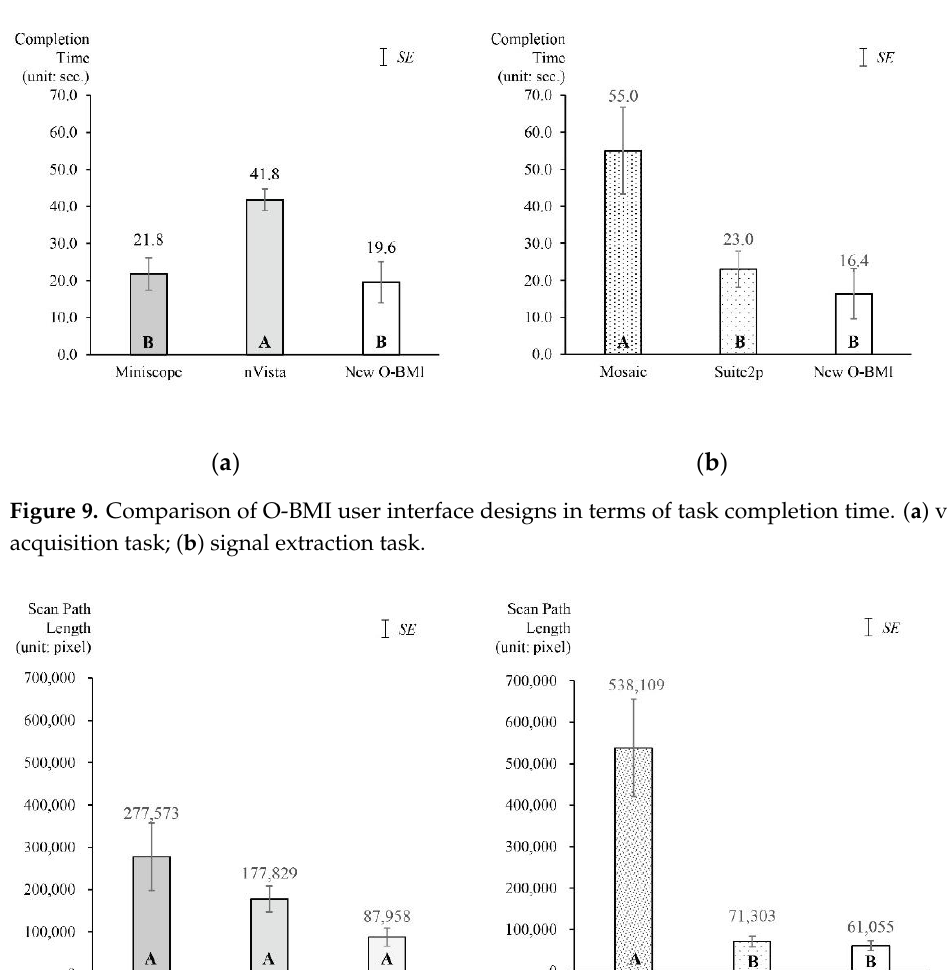
Figure 9. Comparison of O-BMI user interface designs in terms of task completion time. ( a ) video acquisition task; ( b ) signal extraction task.